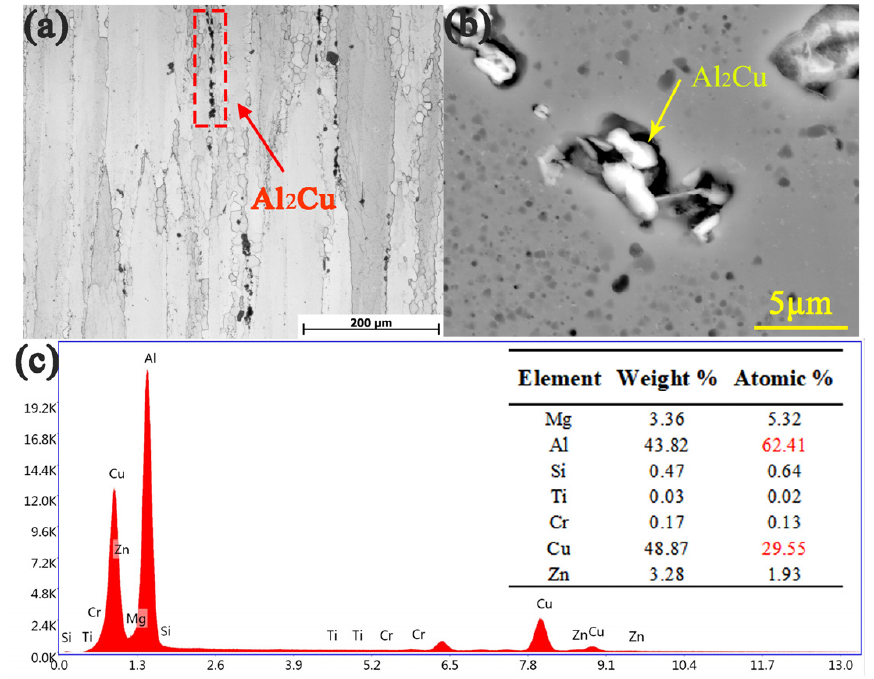
Figure 3. ( a ) OM and ( b ) SEM micrographs on the RD-ED plane of the extruded 7075 Al alloy, ( c ) EDS spot scan results of particles.